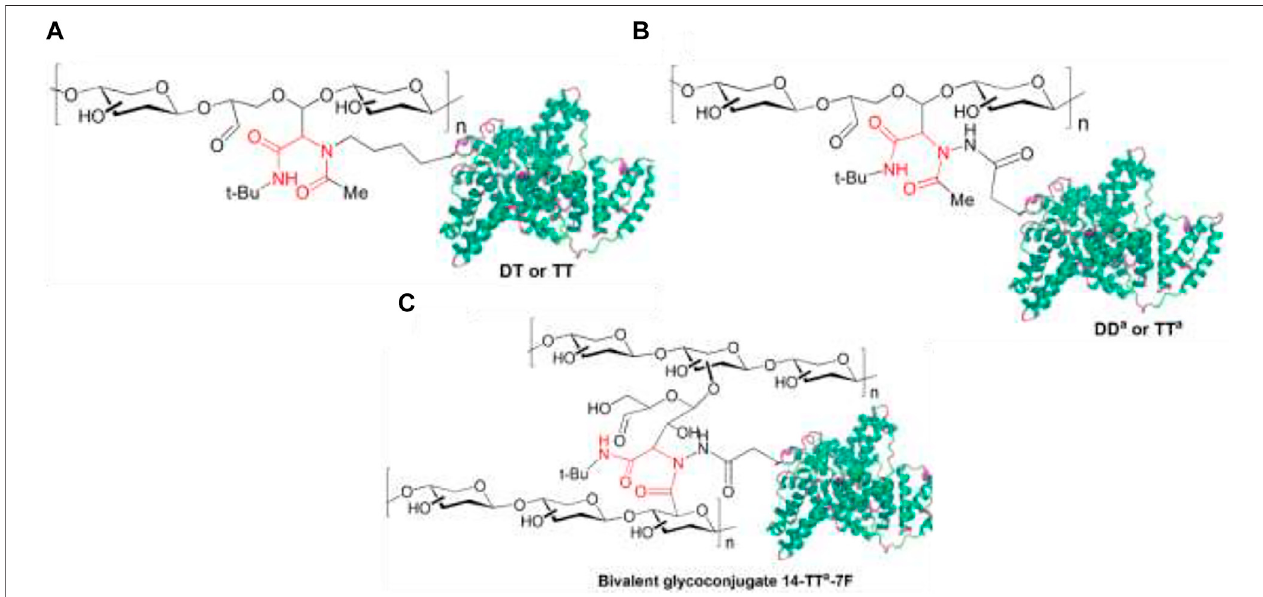
FIGURE 15 | Final products obtained from protein immobilization, labeling, and glycoconjugate through (A) multicomponent conjugation (MCC) of oxo- functionalized capsular polysaccharide (CP) to nonactivated diphtheria (DT) and tetanus toxoids (TT); (B) hydrazide-activated DT and TT (DDa or TTa), and (C) MCC of two CPs to hydrazide-activated TT for the obtention of multivalent glycoconjugate vaccines. The most important covalent bond between entities is highlighted in red.